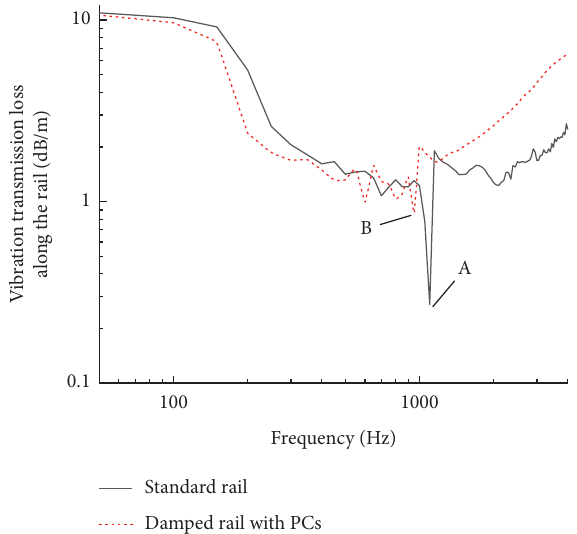
Figure 7: Vibration finite models of half-track, standard rail, and damped rail with honeycomb PCs.